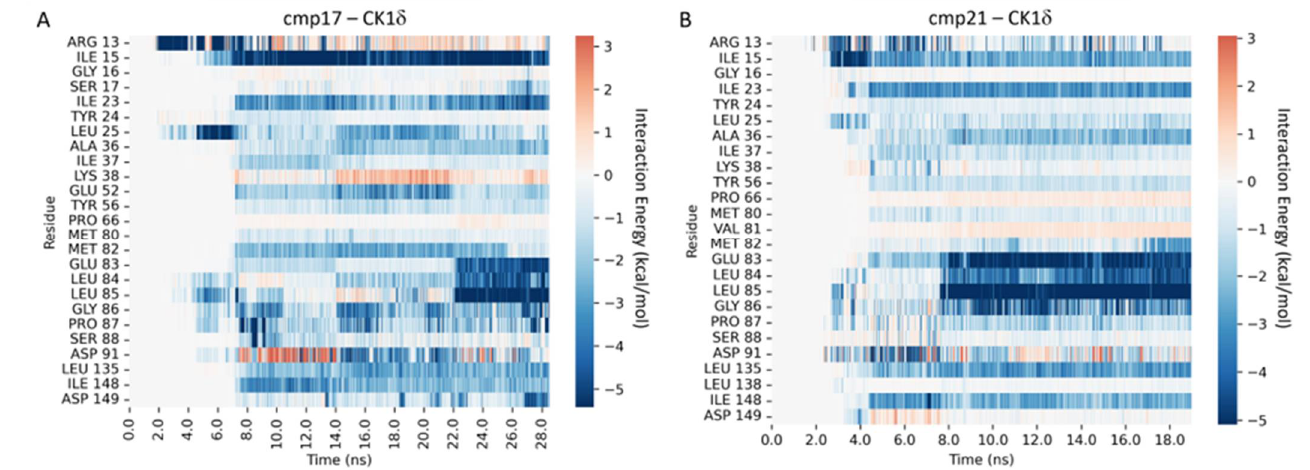
Figure 8. Per-residue decomposition of the protein–ligand interaction energy descriptive of the recognition process between protein kinase CK1 δ and either the “dual anta-inhibitor” (compound 17 ) ( A ) or compound 21 ( B ) sampled with Supervised Molecular Dynamics (SuMD) simulations.